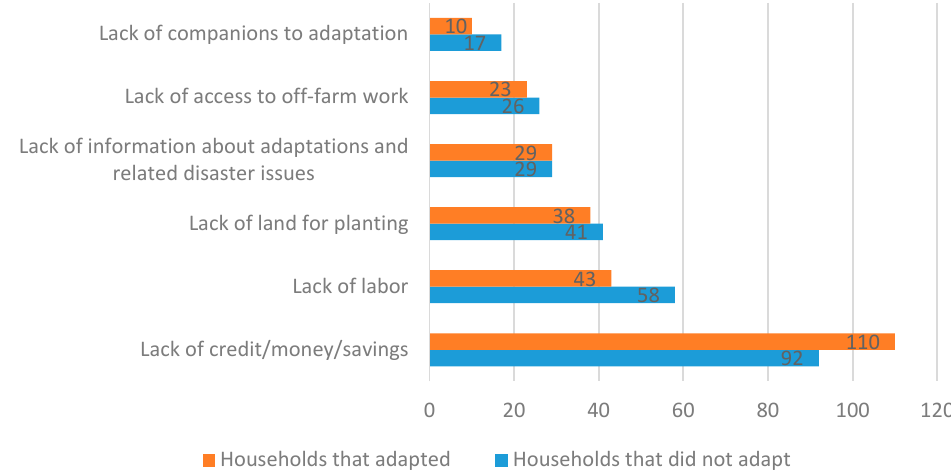
Figure 4. Barriers to adaptation strategies (% of respondents).